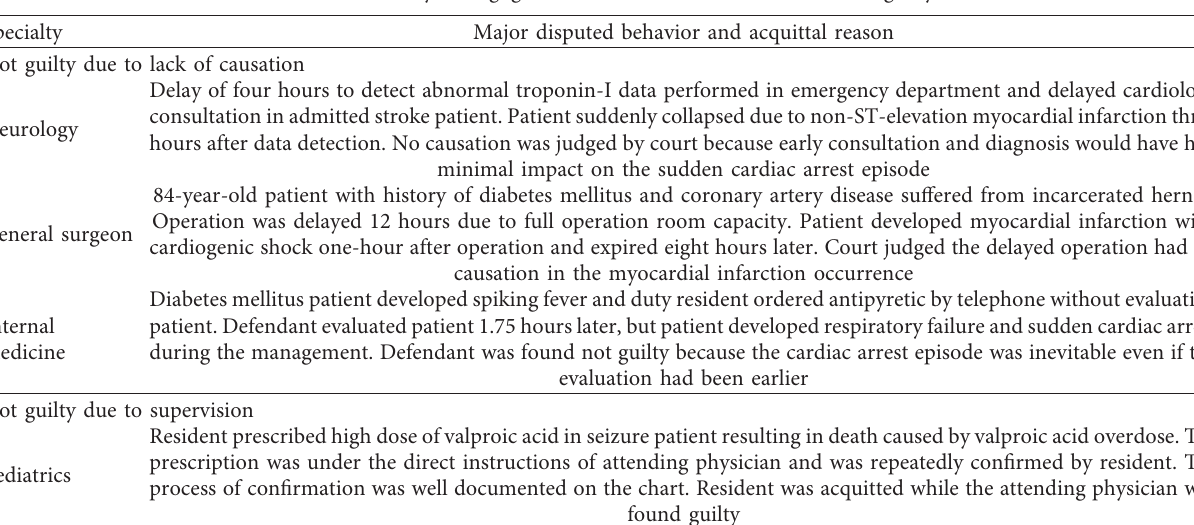
Table 3: Summary of negligent behaviors in defendants found not guilty.